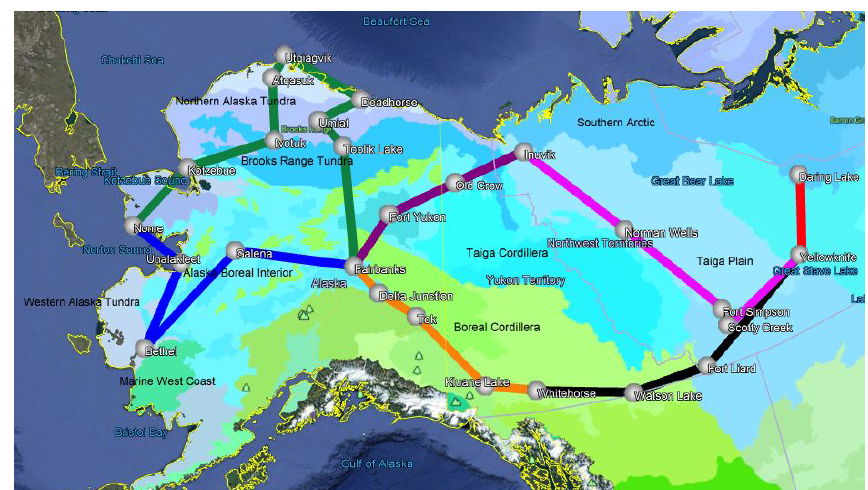
Figure 1. The Arctic-CAP surveys were designed to sample the Arctic boreal ecosystems of the ABoVE domain. Black text labels represent the six ecoregions covered by this study, and white text denotes cities and states or provinces. Gray dots depict the locations on which the Arctic-CAP vertical profiles were centered (© Google Earth). Flight track colors represent extent of each (of seven) daily flights (see Fig. 3).